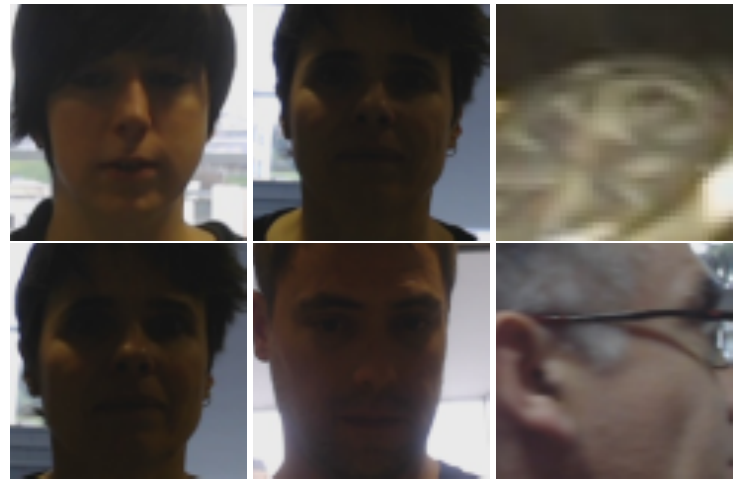
Figure 8. Examples of re-identification failures across floors. The upper row corresponds to probes and the bottom row to the matched image from the gallery. Observe that a face detection error is matched with another detection